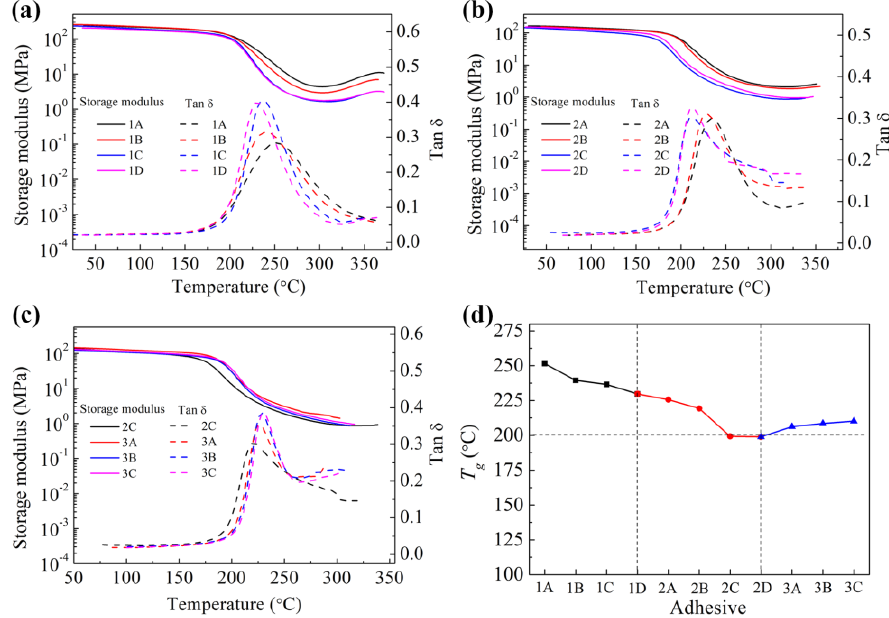
Figure 4. DMA curves of ( a ) epoxy-modified BMI resin; ( b ) PEK−C-toughened epoxy-modified BMI resin; and ( c ) and PEK − C/core–shell polymer co-toughened epoxy-modified BMI resin. ( d ) T g s of resin; and ( c ) and PEK−C/core–shell polymer co-toughened epoxy-modified BMI resin. ( d ) T g s of different modified BMI adhesives. different modified BMI